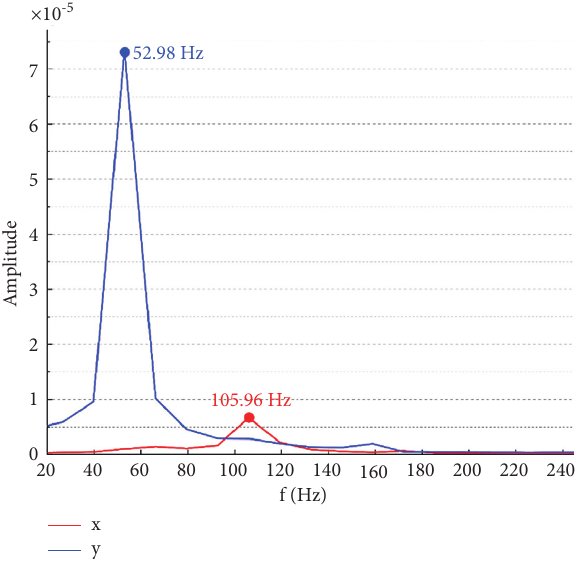
Figure 29: X- and Y -axis vibration displacement frequency-do- main curves.